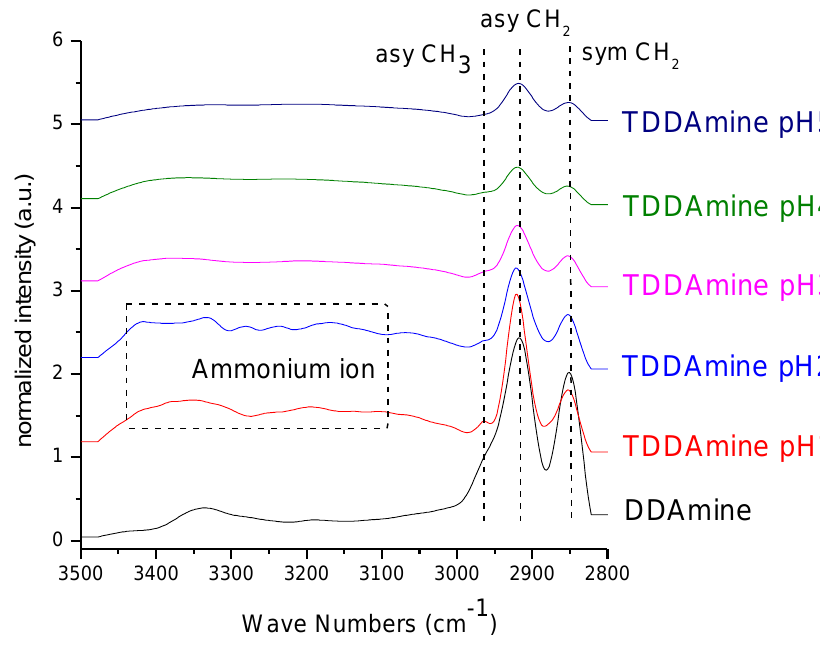
at pH 1, 2, 3, 4 and 2